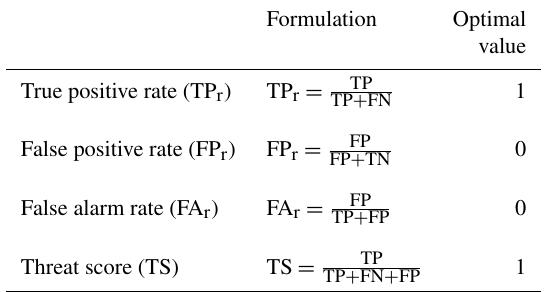
Table 1. ROC metrics (according to Staley et al., 2013). Formulation Optimal